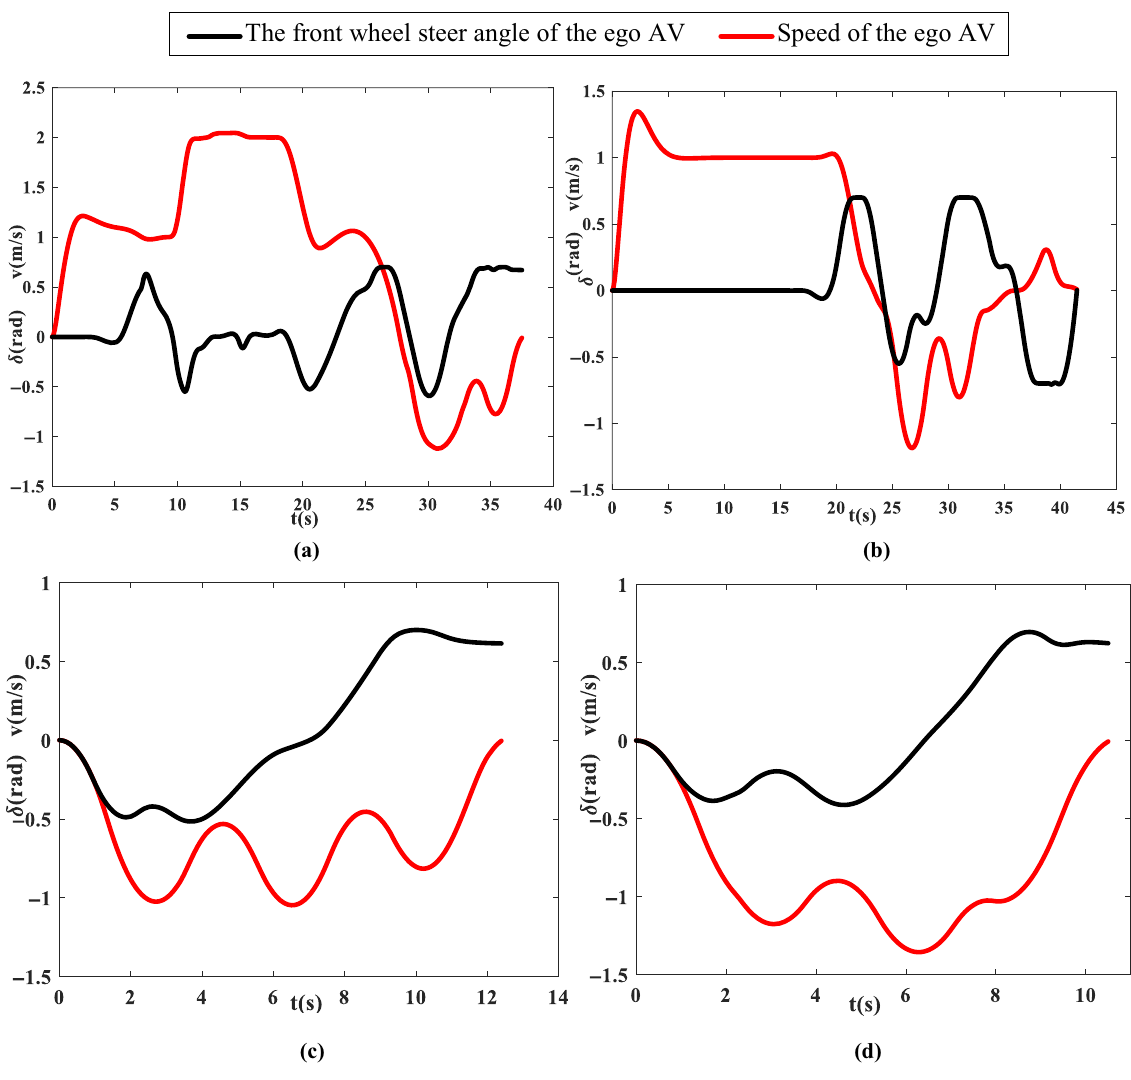
Figure 9 Control pro fi les planned by our method The front wheel steer angle of the ego